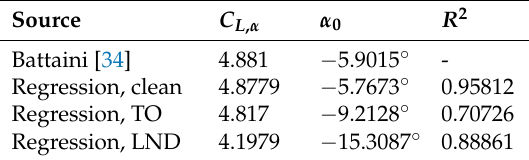
Table 2. Results on the estimation of C L , α and α 0 .